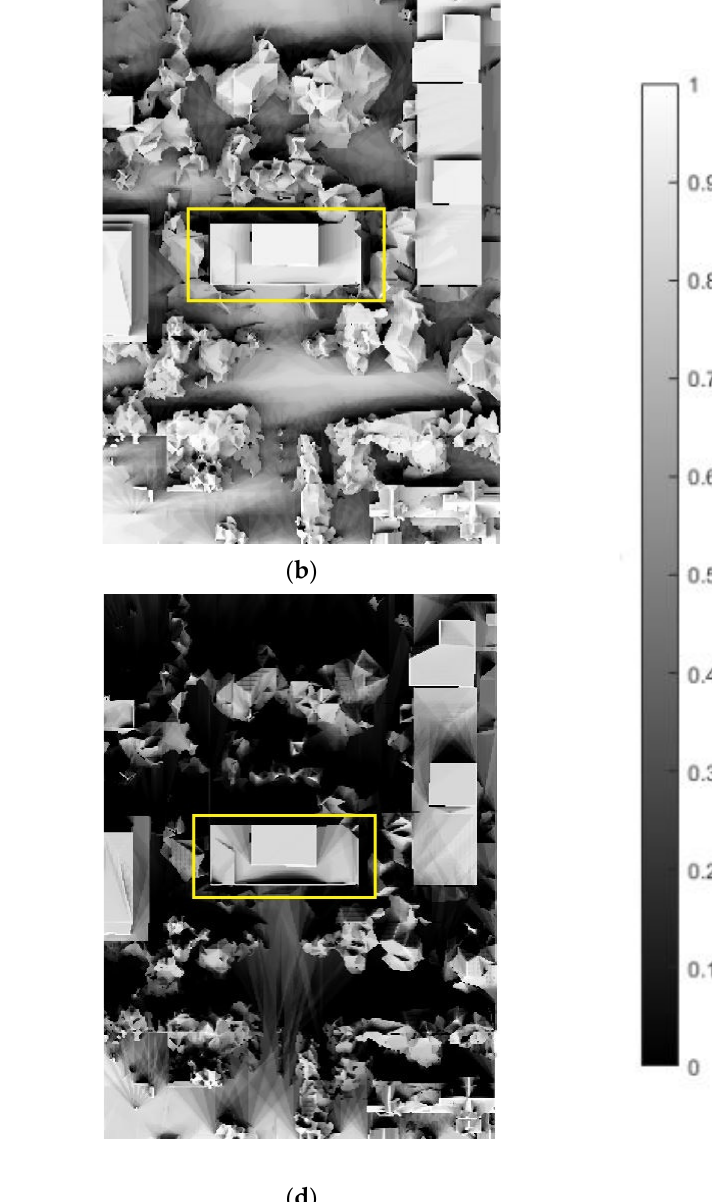
Figure 11. Average brightness score for the ADMIN building in ( a ) spring, ( b ) summer, ( c ) fall, and ( d ) winter.